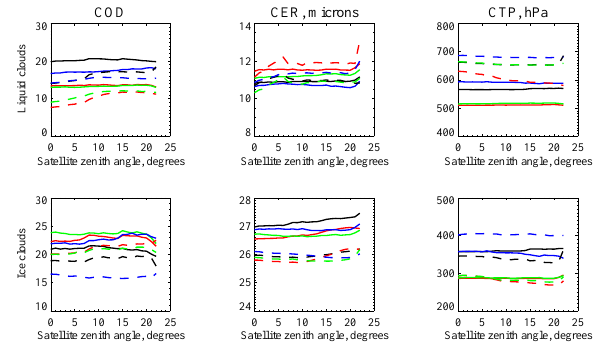
Fig. 7. Mean retrieved cloud properties as a function of satellite zenith angle. The top row shows results for liquid clouds, and the bottom ice clouds. From left to right, the columns show the COD, CER (µm) and CTP (hPa). In all figures, solid lines indicate re- trievals over land and dashed over sea. Black lines indicate the region 23 ◦ N–46 ◦ N, red 0 ◦ N–23 ◦ N, green 23 ◦ S–0 ◦ N, and blue 46 ◦ S–23 ◦